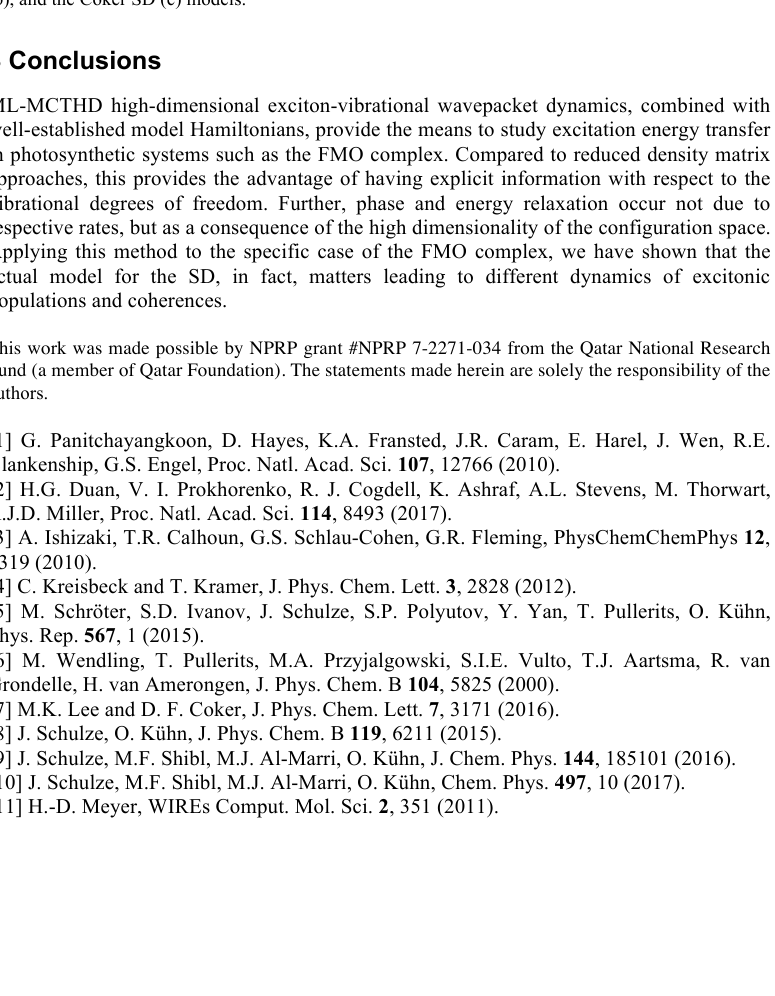
Fig. 2 . Time-averaged exciton density matrix elements for the pure excitonic (a), the Wendling SD (b), and the Coker SD (c)